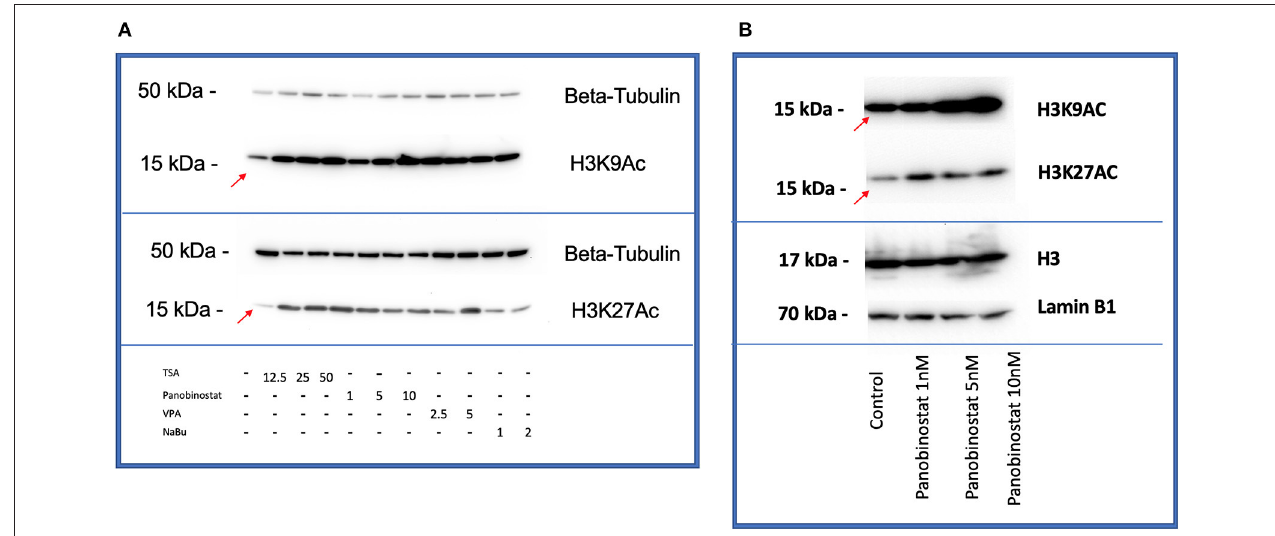
FIGURE 4 | HDACi effectively increases H3K9 and H3K27 histone acetylation in CEF. (A) All compounds showed an increase in acetylation of H3K9 (top) and H3K27(bottom) by Western blot comparing with non-treated control band (red arrows are pointing at bands related to non-treated controls). β -tubulin was used as a loading control. Blots were repeated two times using two different CEF lines. (B) Panobinostat 1-, 5-, and 10-nM treatment increased H3K9, H3K27 acetylation compared with non-treated control (red arrows are pointing at bands related to non-treated controls). Total H3 and Lamin B1 were used as loading